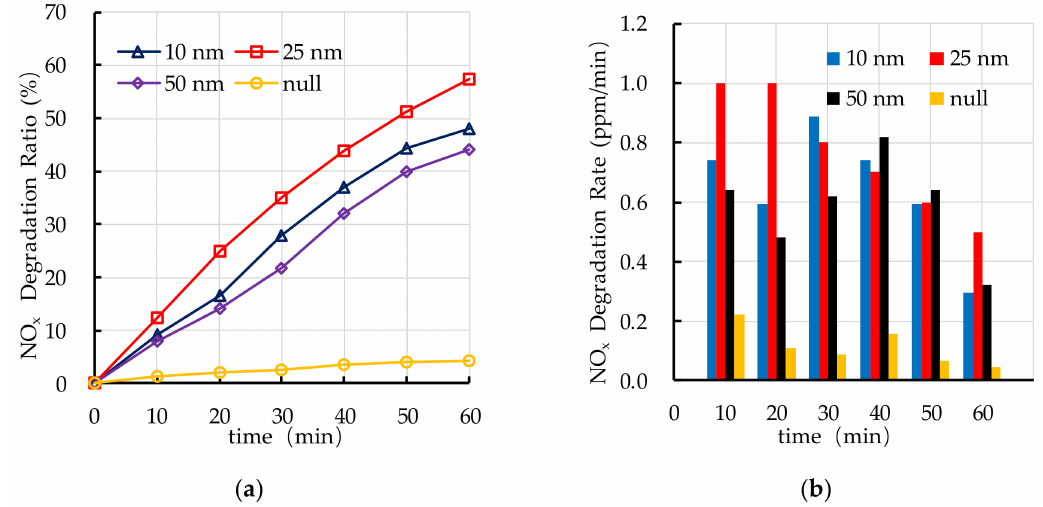
Figure 11. E ff ect of TiO 2 particle size on photocatalytic degradation of NO x : ( a ) NO x degradation ratio; ( b ) NO x degradation rate.